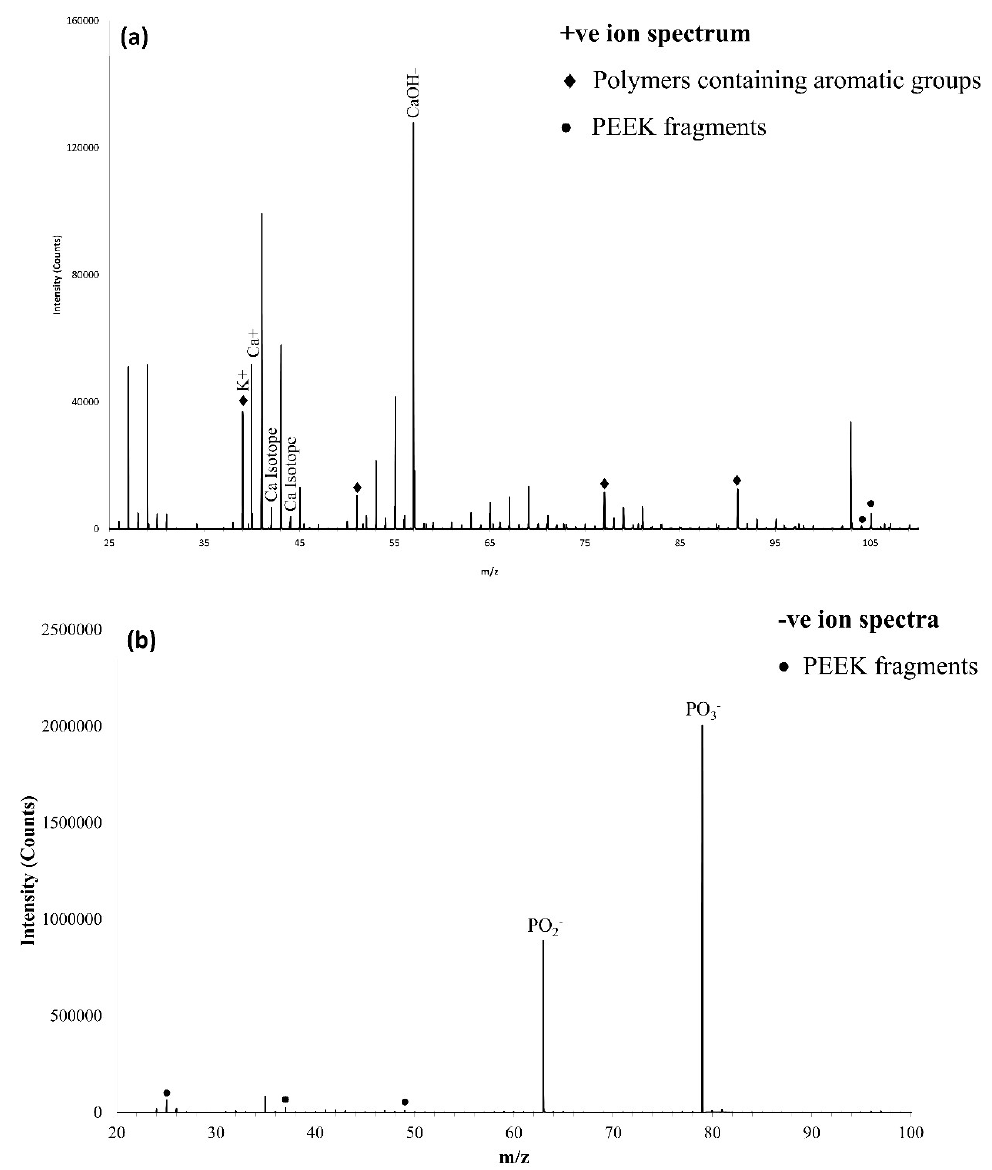
Figure 12. ToFSIMS spectra for ( a ) positive ions HA600 and ( b ) negative ions HA600.